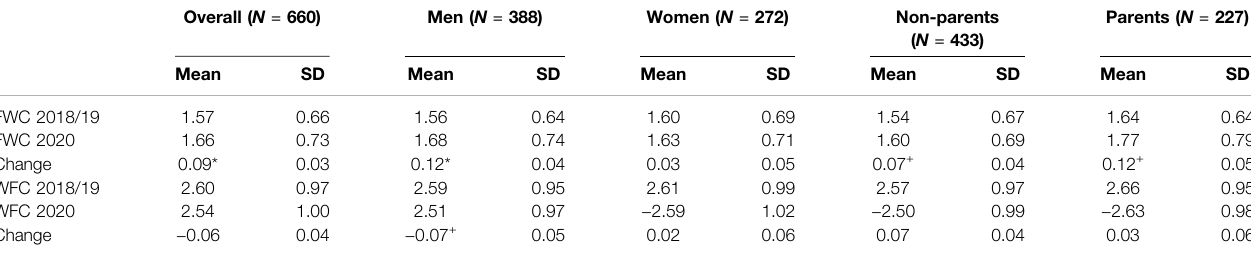
TABLE 3 | Descriptive statistics overall, gender, and parenthood. Overall ( N = 660)